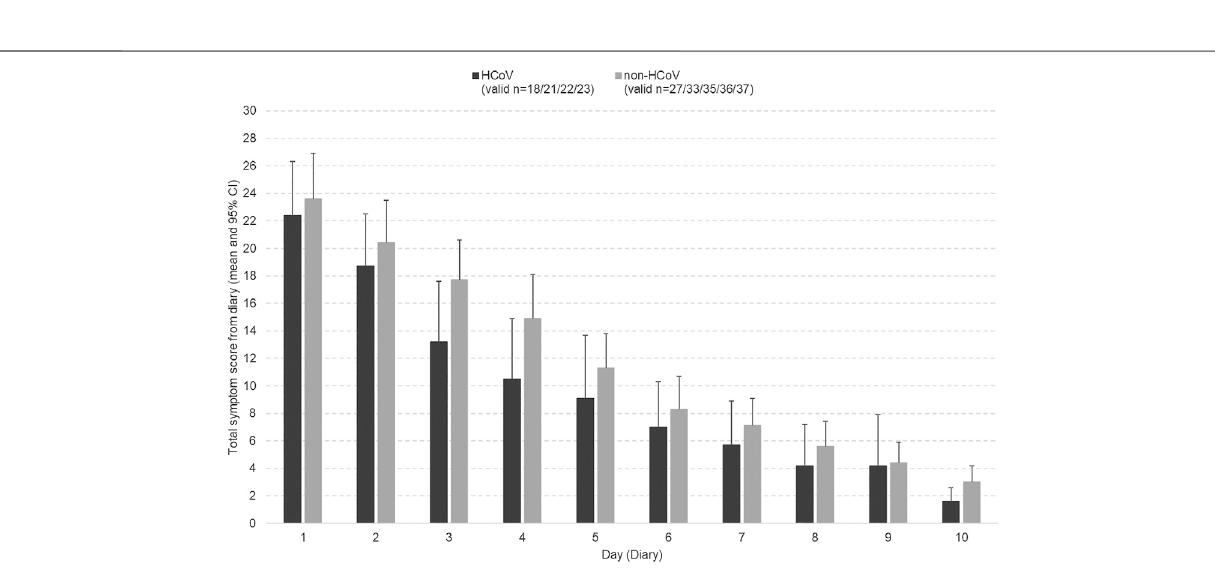
Frontiers in Pharmacology |